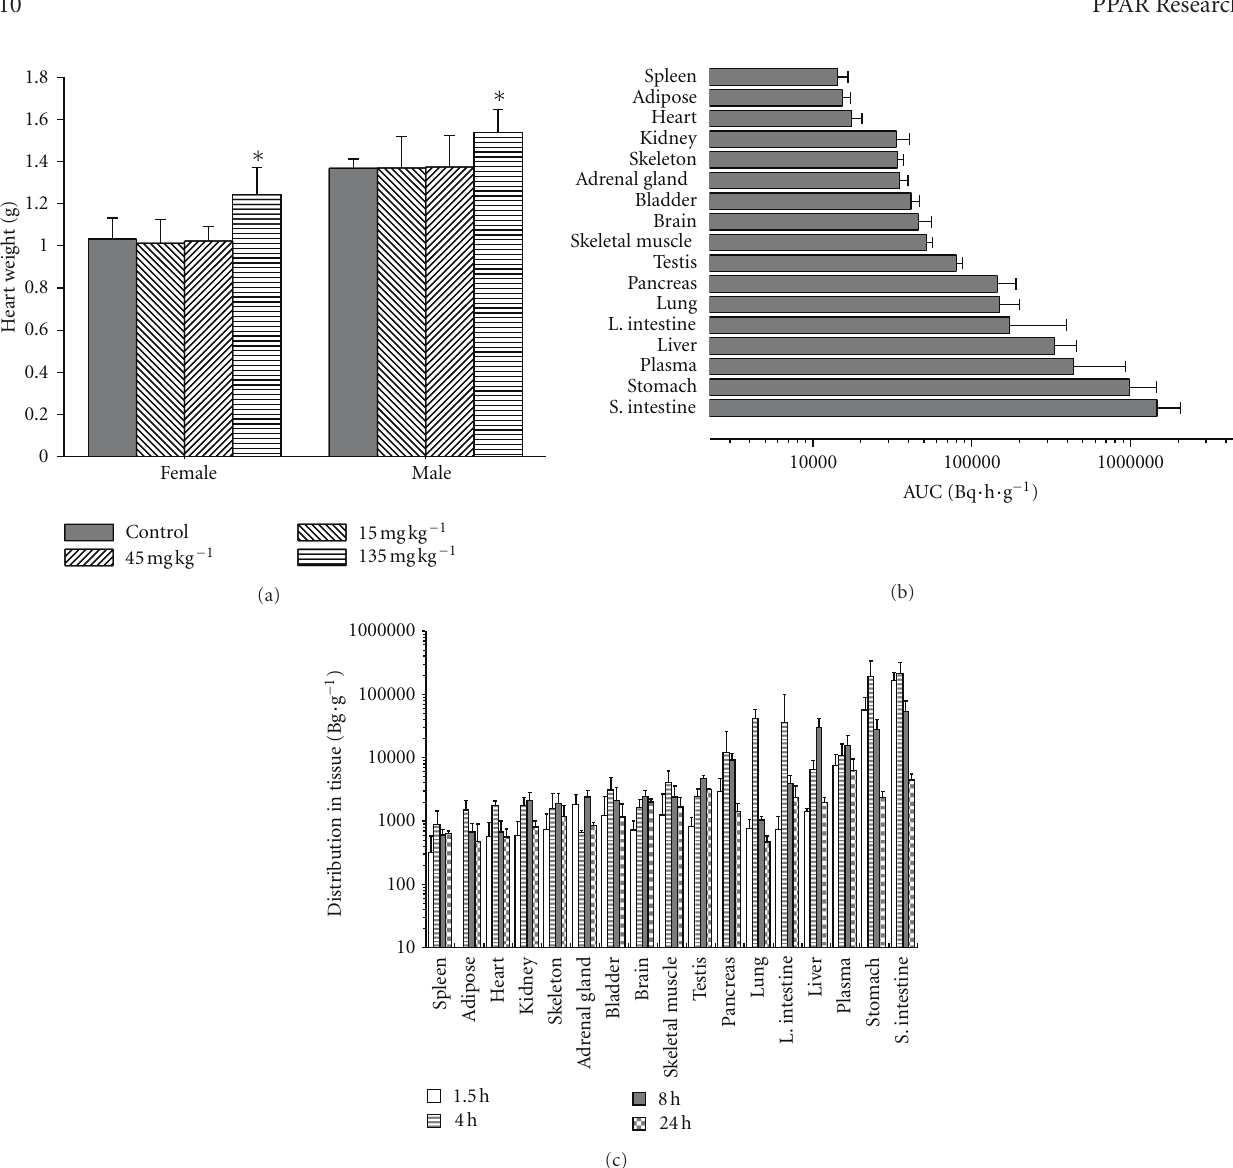
Figure 5: Influence on heart weight and tissue distribution of chiglitazar in rats. (a) Wistar rats were orally administered daily with chiglitazar at the dose of 15, 45 and 135 mgkg − 1 for 6 months. 24h after the last dosing, animals were sacrificed and the heart weight was evaluated. ∗ P < 0 . 05 compared with control; n = 5 per group. (b) Male Wistar rats were orally administered with a single dose of 3 H-chiglitazar at 12.5mg kg − 1 (radiation dose 31.7 MBqkg − 1 ). Rats were sacrificed at 1.5, 4, 8, and 24h after treatment ( n = 5 per time point), and various tissues/organs as indicated were taken for radioactivity measurement. The accumulated area under curves through 0 to 24h (AUC 0–24 ) was calculated based on individual tissue distribution measured at each time point. (c) The time course distribution of chiglitazar in di ff erent tissues at individual time point (1.5, 4, 8, 24h). Data are expressed as mean ±